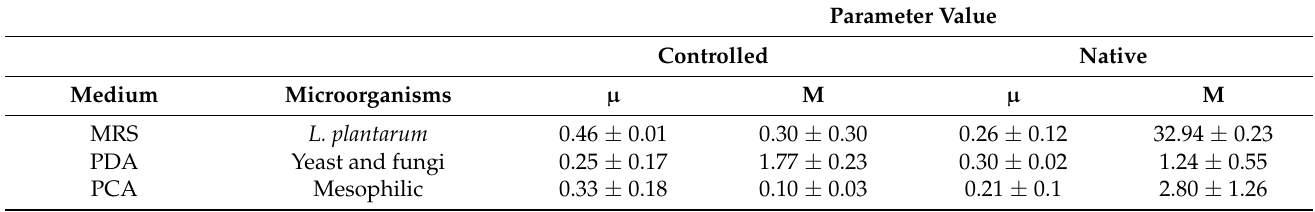
Table 3. Kinetic of growth with the Gompertz’s predictive model (Equation (2)) [13] of native and controlled fermentation ( L. plantarum ) of the C. ficifolia juice (mean ± S.D., n =